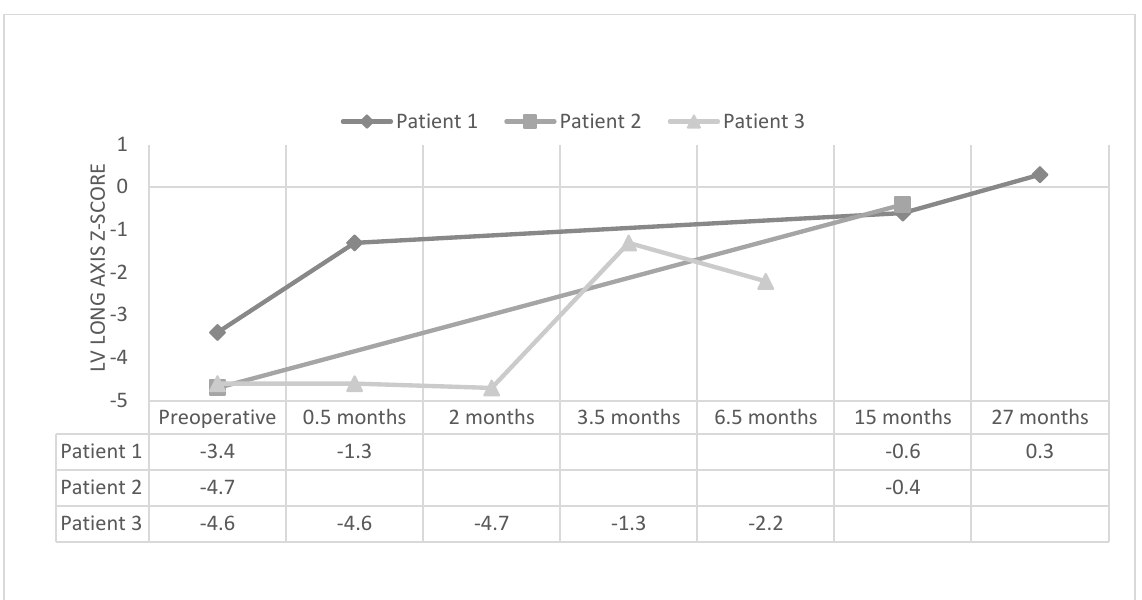
Figure 3. Left ventricular long-axis z-score in patients before and after left ventricular recruitment.